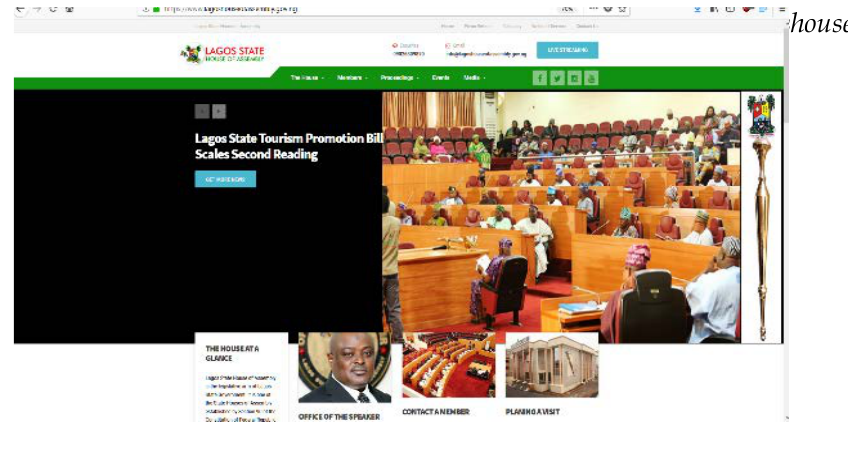
Figure 4: Lagos State House of Assembly Official Website (www.lagoshouseofassembly.gov.ng)